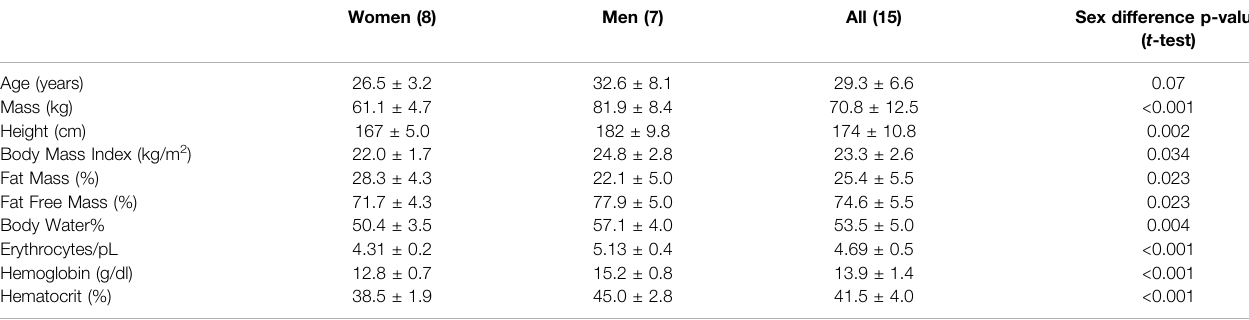
TABLE 1 | Anthropometric and hematologic parameters of 15 healthy men and women. Data as mean ± SD.